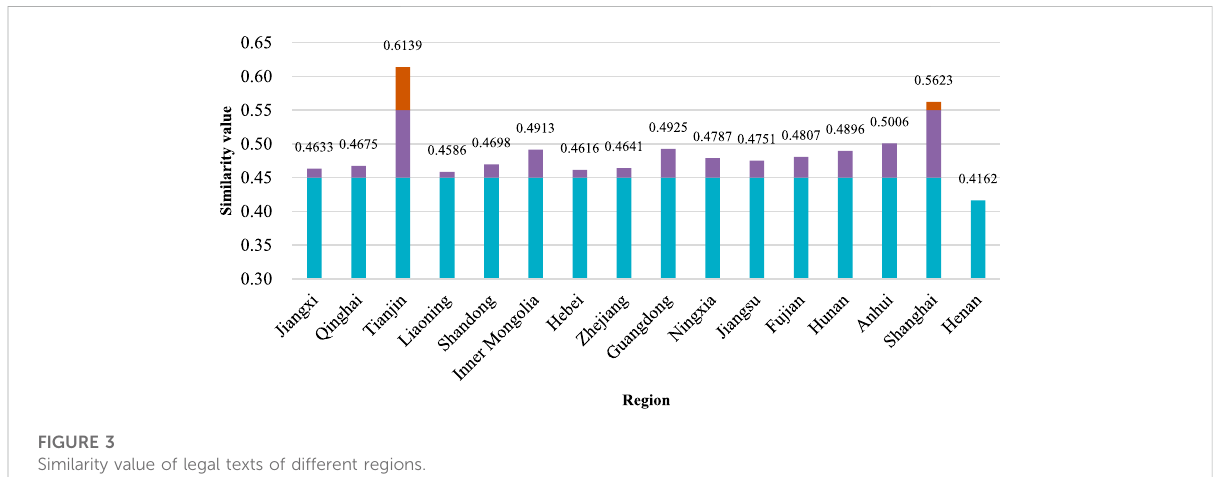
FIGURE 3 Similarity value of legal texts of different